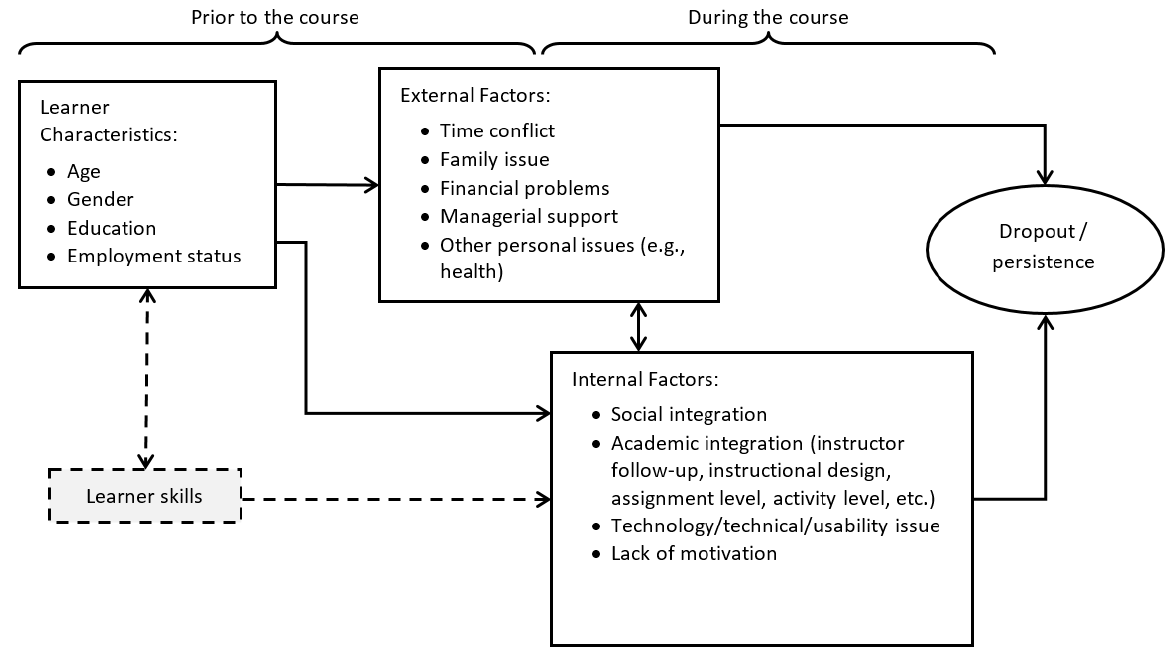
Figure 1. Theoretical model of drop-out levels among adult students following on-line courses (Park,